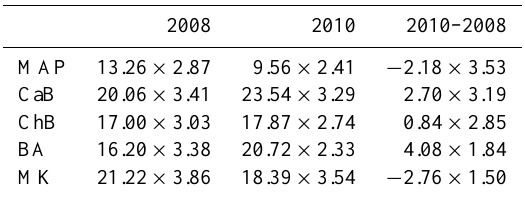
Figure 11: Scheme of the freshwater circulation during a negative phase of the AO (right) and a positive phase of the AO (left), derived from Steele and Boyd (1998), Johnson and Polyakov (2001), Proshutinsky et al. (2002, 2009), Condron et al. (2008), Morison et al. (2012). During anticyclonic regime (negative phase of AO), Beaufort Gyre anticyclonic circulation is enhanced and Ekman Pumping is very strong as a result. Therefore, a large amount of